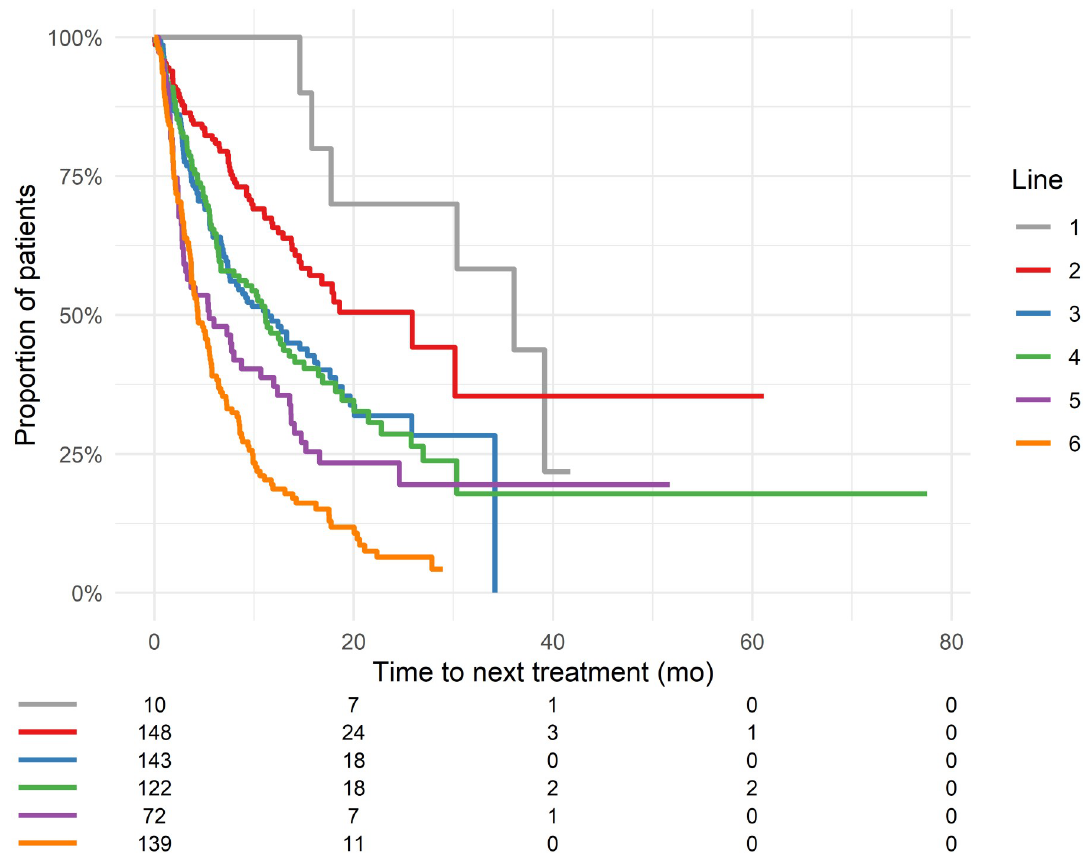
Fig 2. Time to next treatment depending on the timing of daratumumab therapy. Patients at risk is shown below each figure. A: TNT for all combinations of daratumumab depending on timing. Cox-regression analysis showed longer TNT in early lines (p <